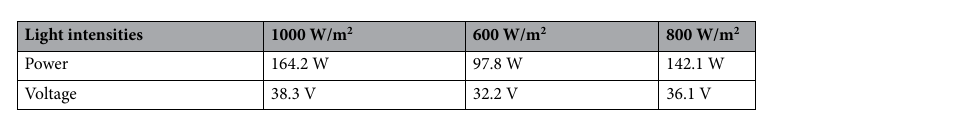
Table 2. The power and voltage of the maximum power point under different light